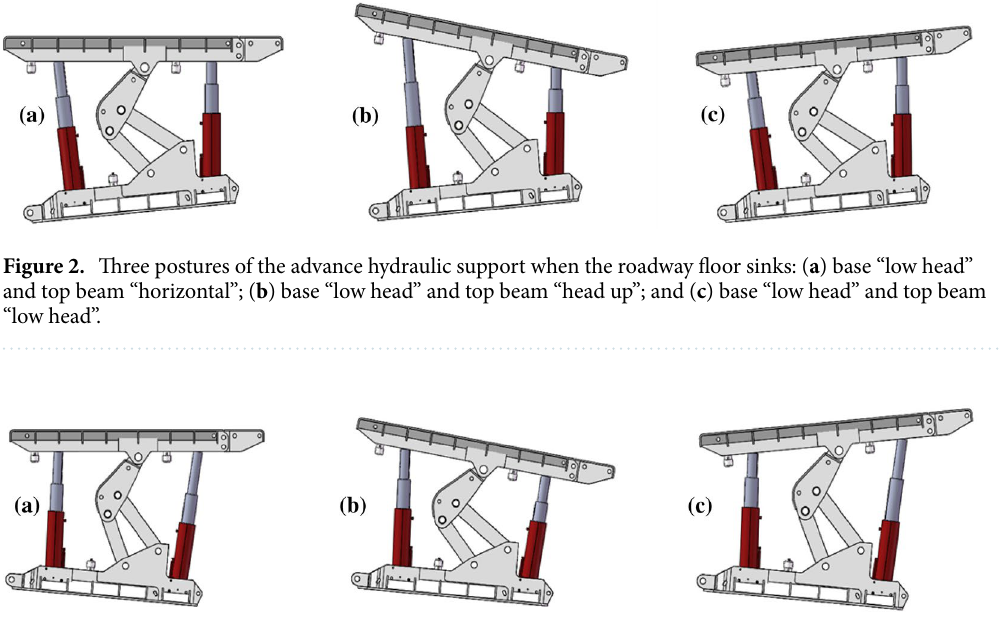
Figure 3. Three postures of the advance hydraulic support when the roadway floor is bulging: ( a ) base “head up” and top beam “horizontal”; ( b ) base “head up” and top beam “head up”; and ( c ) base “head up” and top beam “low